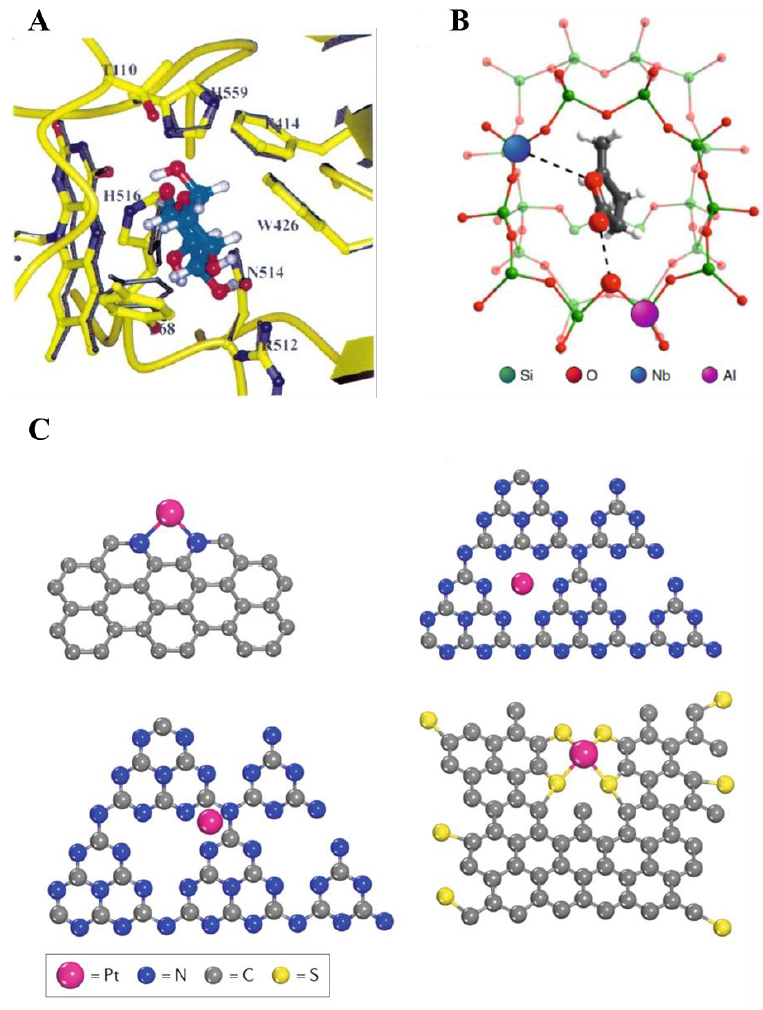
Figure 1. ( A ): Stereoview of the active site of glucose oxidase with the modelled substrate β -d- glucose [4]. Reproduced with permission of the International Union of Crystallography. ( B ): The structure of γ -valerolactone within zeolite pores as obtained using in situ X-ray diffraction data [5]. Reprinted with permission from [5]. Copyright 2020, Nature Springer. ( C ): Single Pt atoms bounded to N- rich or S- rich regions in doped carbonaceous supports [10]. Reprinted with permission from [10]. Copyright 2018, Nature Springer.